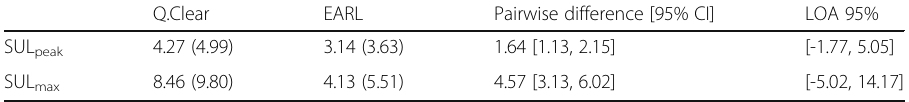
Table 3 Median (IQR) of lesion SUL peak and SUL max for the Q.Clear and EARL protocol, and Bland- Altman comparison details